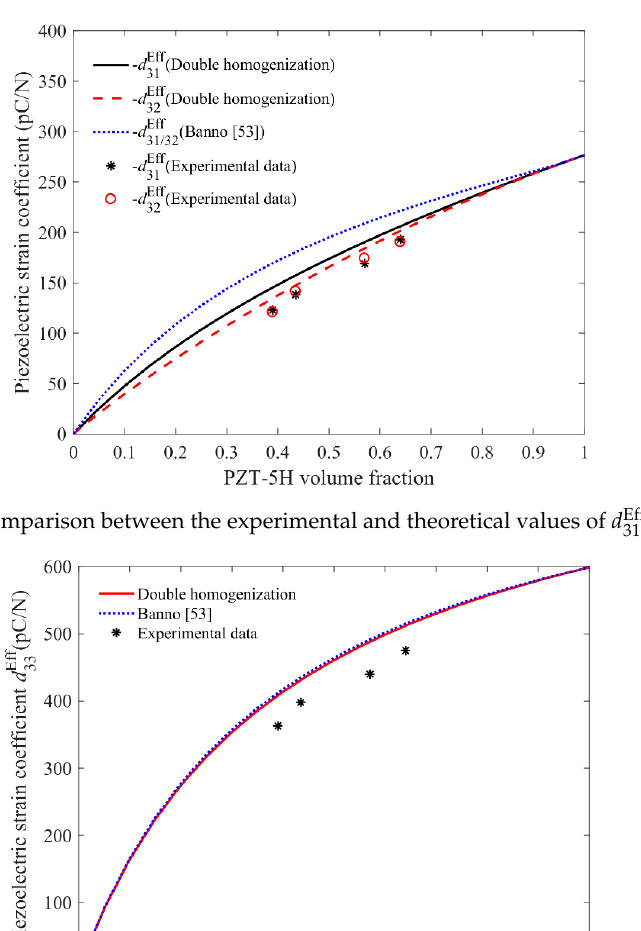
Figure 13. Comparison between the experimental and theoretical values of Eff